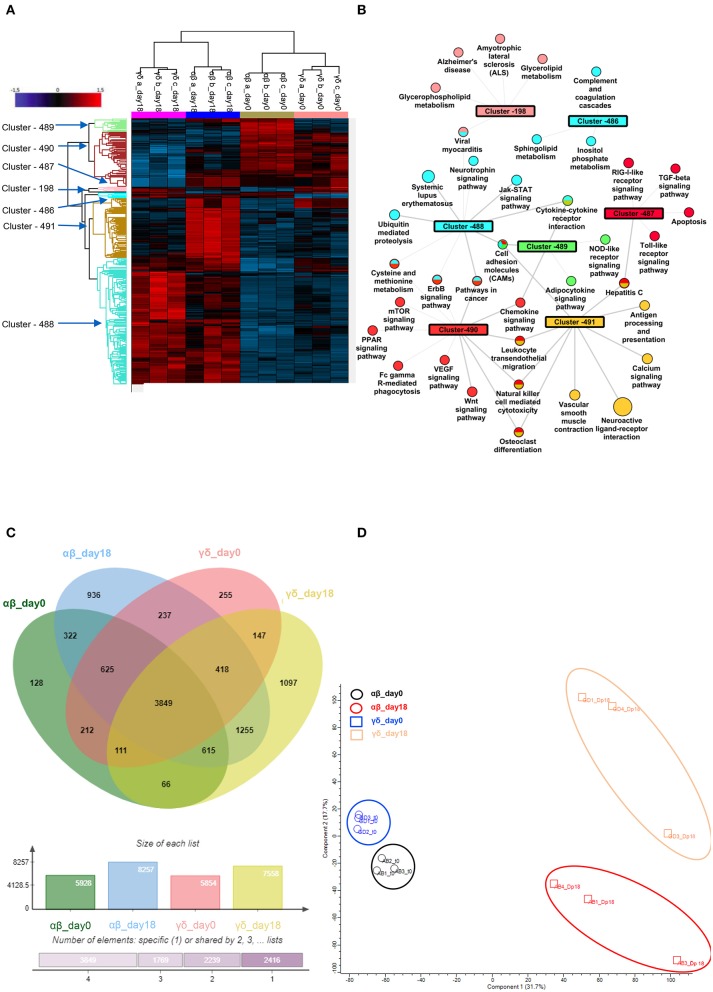
Phospho-proteomic profile of γδ CD40L/pp65 and polyclonally activated αβ-T cells. Anova graphical representation of the differential phosphoproteome pattern in the two populations on day 0 and day+18 after co-culture. (A) shows the heatmap Zscore Signalling Score values of proteins identified as relevant after Photon analysis, as well as the significant clusters on which is calculated a Fisher Test enrichment, using KEGG annotation, downloaded from Uniprot, with a significance threshold of Benjamini-Hochberg FDR < 0.02. The output file is converted into an alluvial plot where different colours are associated with different data sets and the width of flow line for each biological process is related to –log10 (Benjamini-Hochberg FDR < 0.02) of the enrichment. In (B), the data table obtained from the Fisher Test applied on each protein cluster highlighted in the Heatmap is summarised in the network, where the main enriched Kegg annotations are reported. The node size is proportional to –log10 (Benjamini-Hochberg FDR), the edge width is related to Enrichment Factor and the colour identifies the belonging cluster. When a node is shared between different clusters all the reference colours are reported. Venn diagrams summarizing the phosphorylation sites detected in the two populations are reported in (C). Numbers represent the distinct phosphorylation sites in the respective overlapping and non-overlapping areas; the histograms below show the total number of phosphorylation sites involved in the analysed groups. (D) shows the difference between the populations both before and after co-culture by PCA analysis.